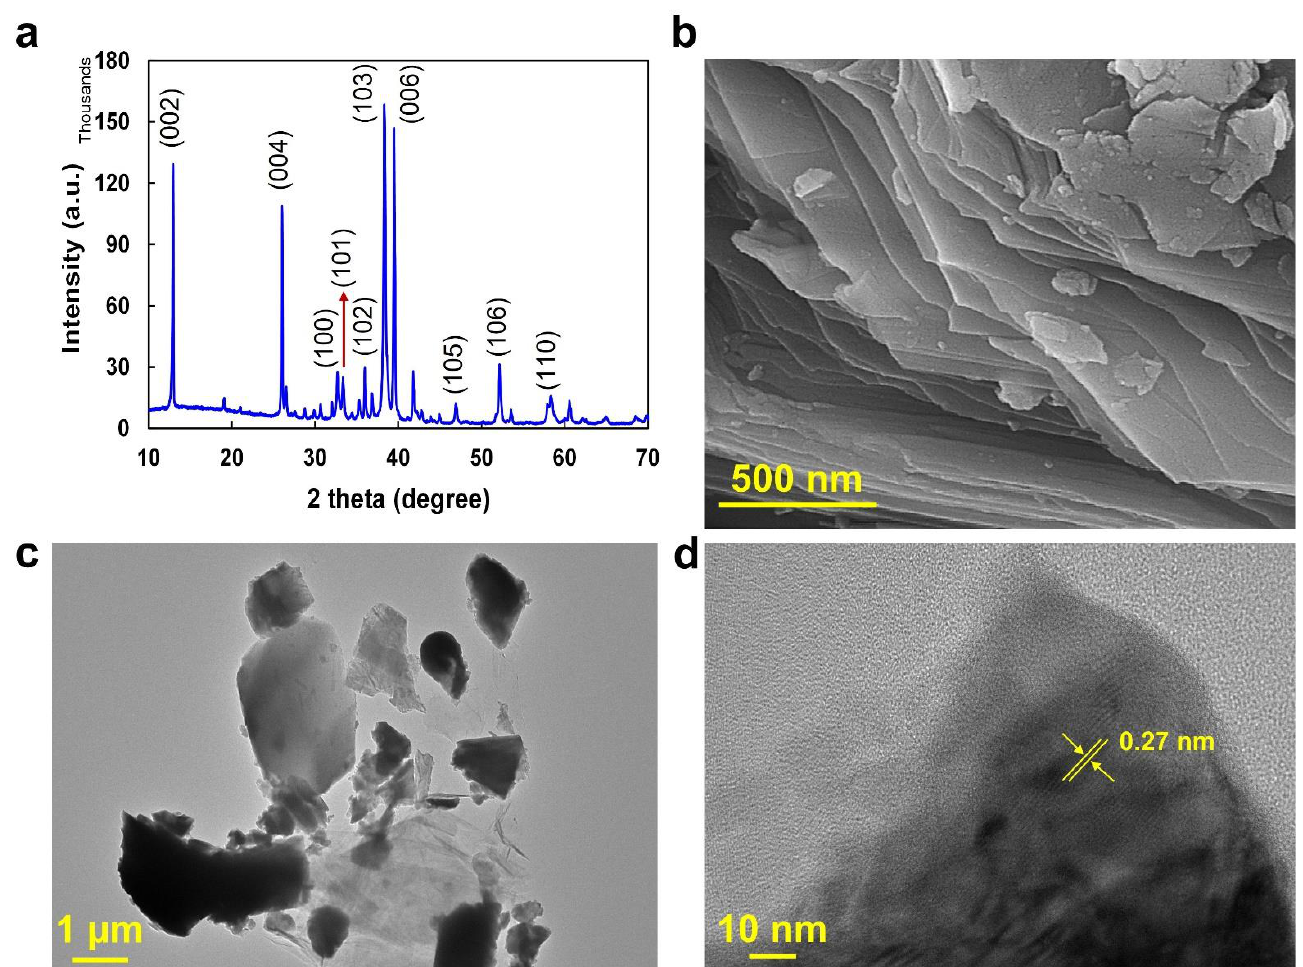
Figure 1. ( a ) XRD pattern, ( b ) SEM, ( c ) TEM, and ( d ) HRTEM micrographs of the Ti 2 SnC MP.